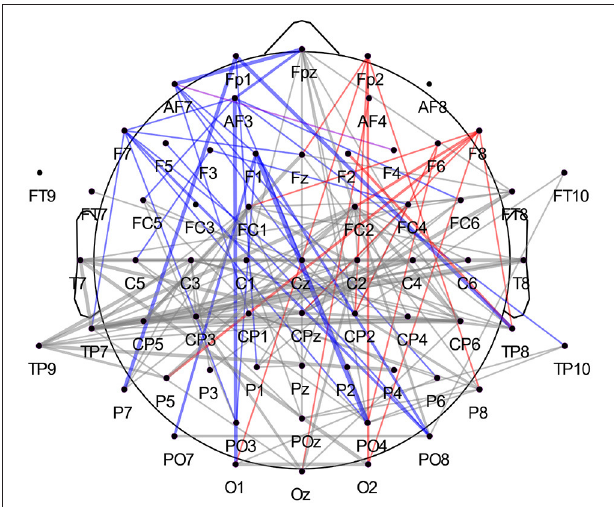
FIGURE 7 | Highest-ranked amplitude time-series correlation features from all frequency bands. When separating correlations involving left frontal channels (in blue, Fp1, AF3, AF7, F1, F3, F5, F7) and right frontal channels (in red, Fp2, AF4, AF8, F2, F4, F6, F8), we observe a high prevalence of the left frontal cortex compared to the right. The analysis was carried out across participants, with 220 features in total (20 per participant). Again, the connection’s width reflects how often the correlation occurred in the main features across participants, with the thicker line representing higher occurrence across subjects. The correlation between AF7 and F4 is plotted in violet and counted as both left- and right-hemispheric frontal correlation.